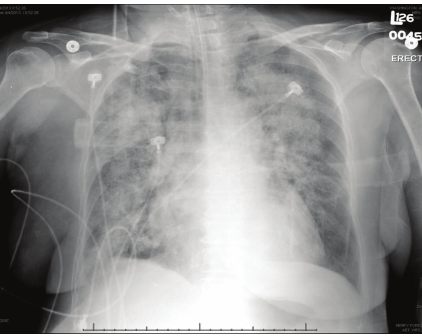
Figure 1: Chest X-ray revealing bilateral perihilar air space opacity. Tiny right pleural effusion with thickening or fluid within the